Question: Briefly state, in one sentence, what is plotted here.
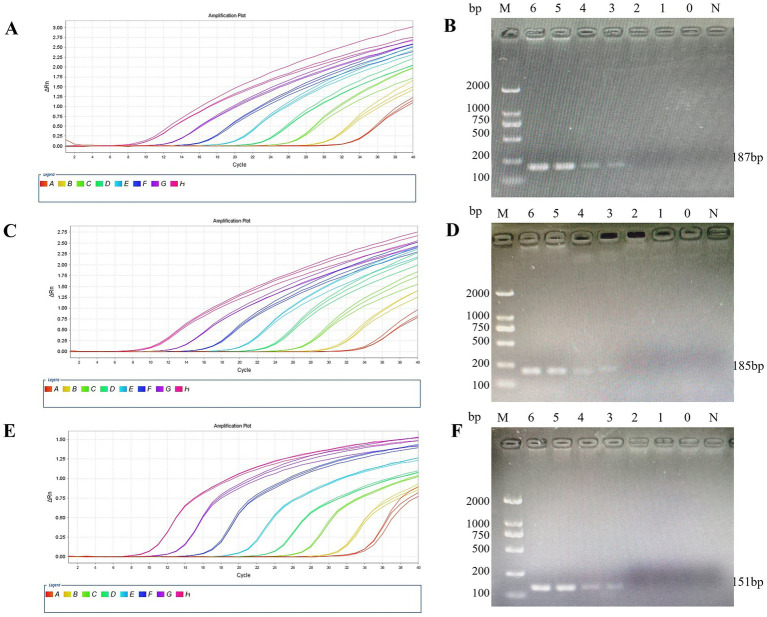
Answer: Sensitivity analysis of the TaqMan multiplex real-time qPCR assay. (A,B) : DTMUV; (C,D) : NDRV; (E,F) : DuCV. A to H means standard template at 10 1 –10 8 copies/μL in turn. 6 ~ 0 means the concentration of 10 6 –10 0 copies/μL in turn; M means marker; N means negative control.